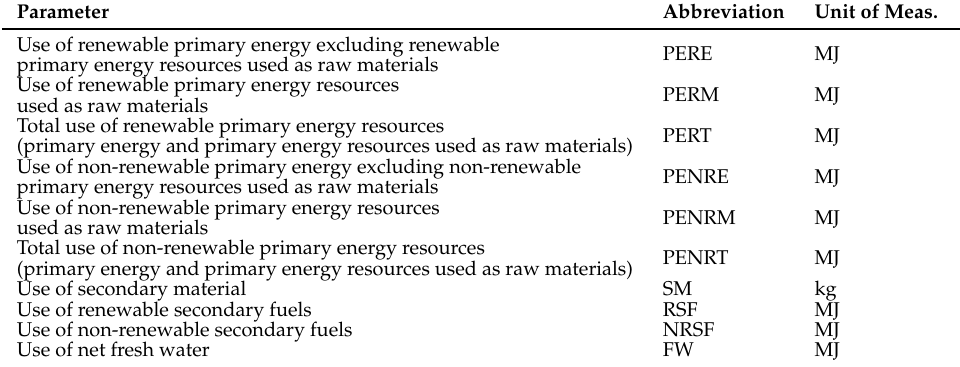
Table 2. Environmental impact parameters related to use of resources.